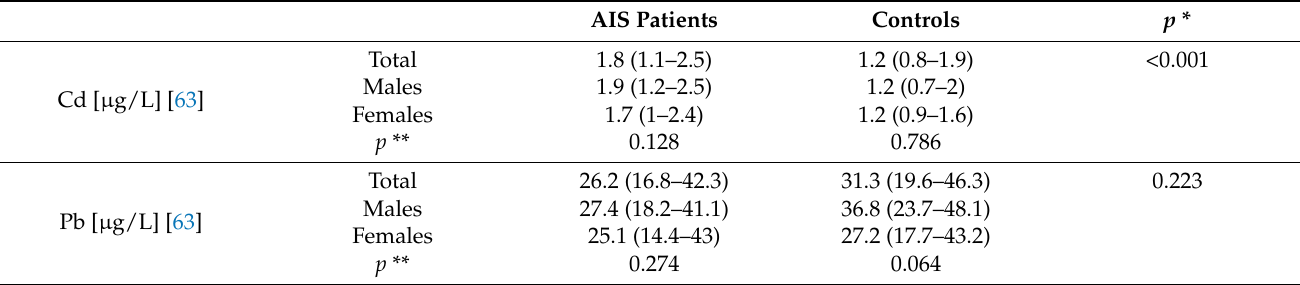
Table 2. The comparison of trace elements status between AIS and